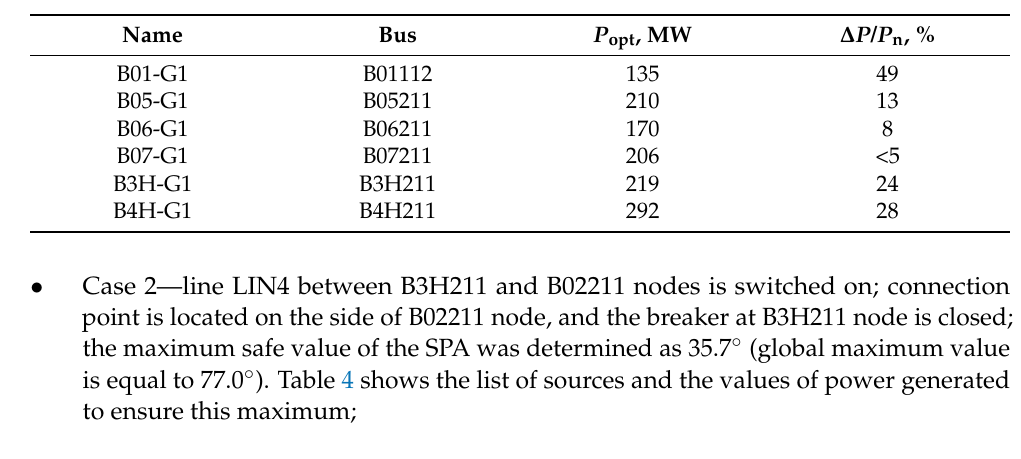
Table 4. List of sources with optimal capacity and expected values of power surges calculated for each generator.